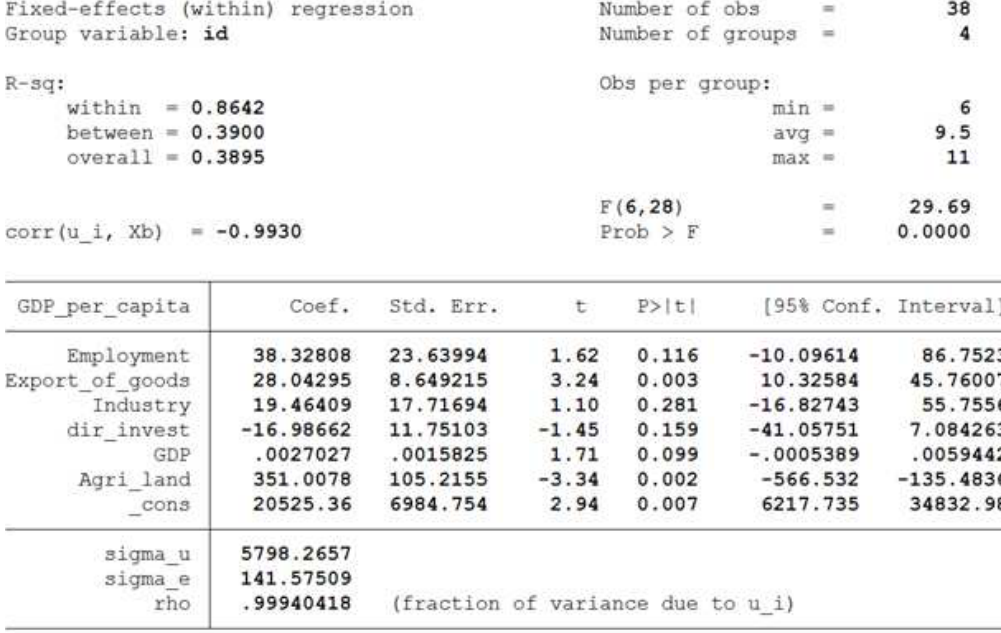
Figure 7. Results of the impact assessment of the share of land cultivated on the level of country’s economic